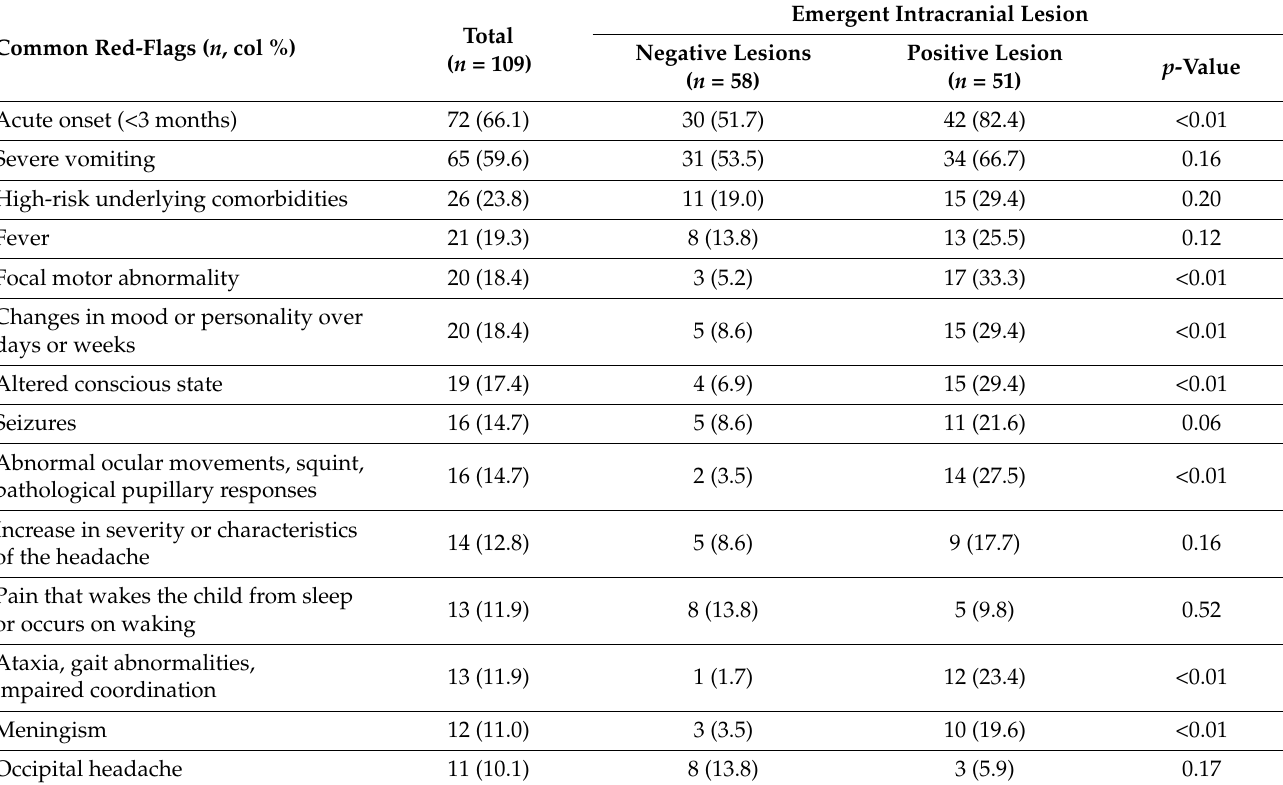
Table 3. Association between red flags and emergent intracranial